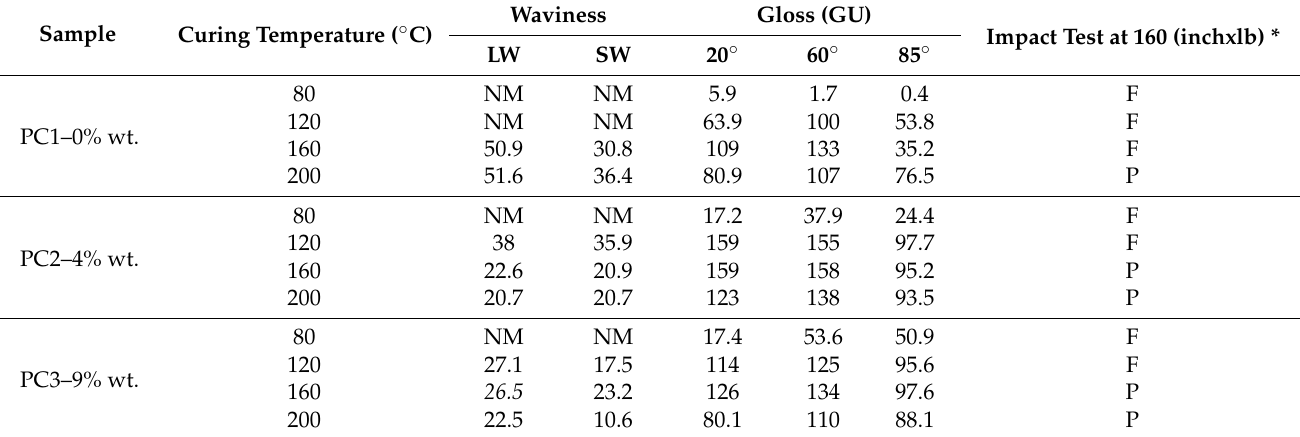
Table 3. The coating film properties for various curing temperatures at a curing time of 30 min.